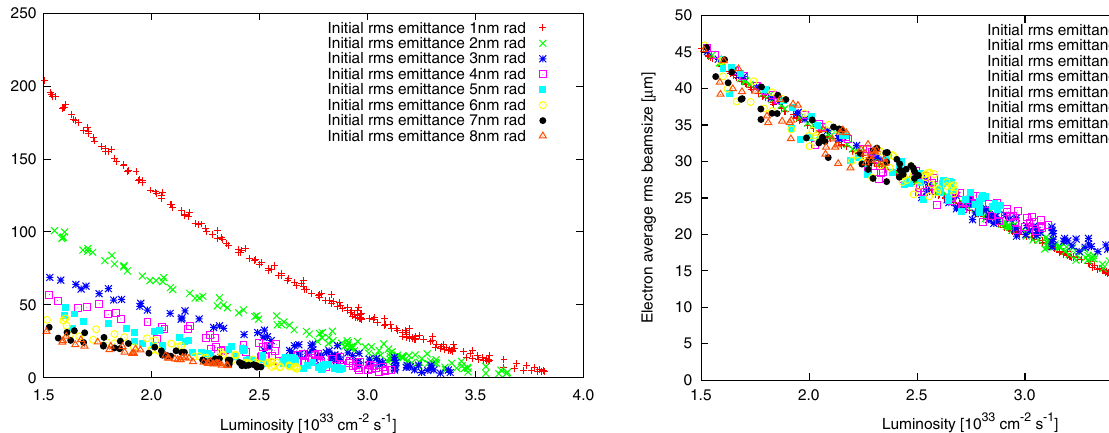
FIG. 11. (Color) Electron beam rms effective emittance after collision as a function of luminosity.